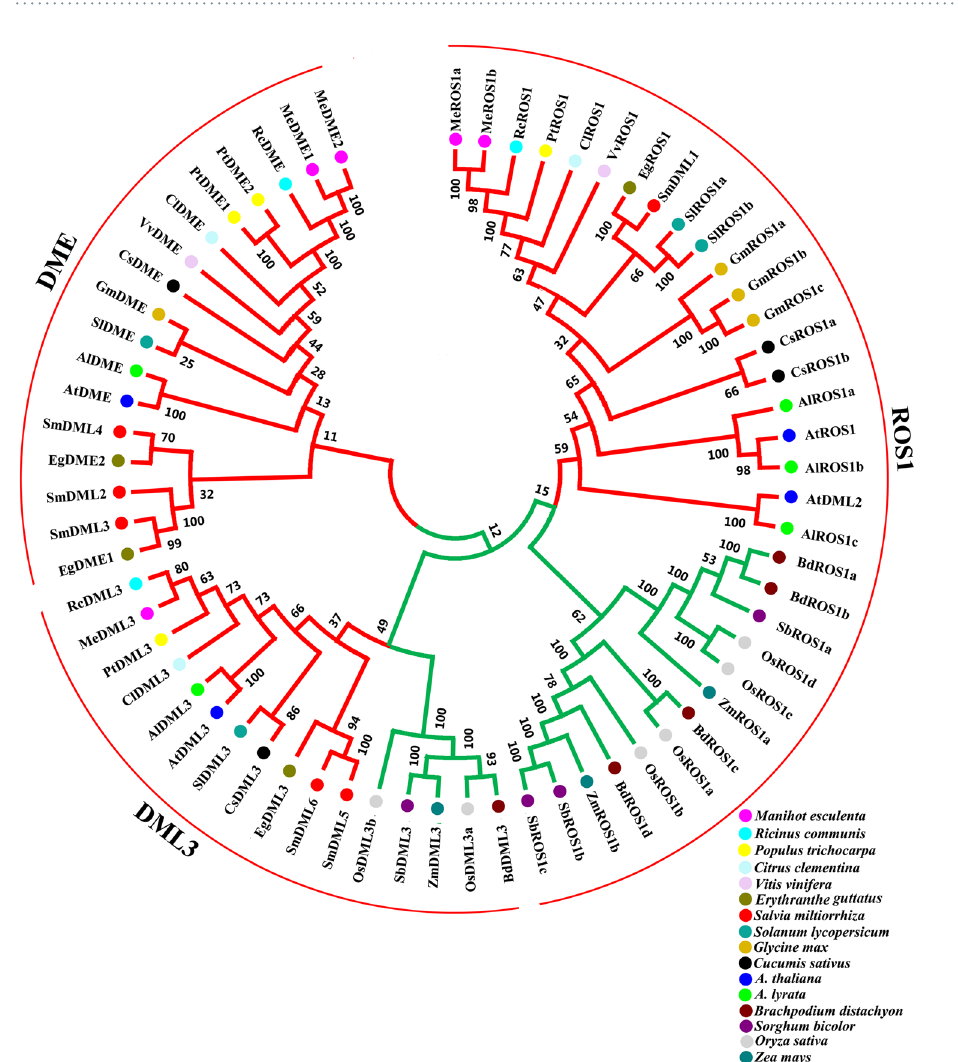
Figure 4. Phylogenetic analysis of DML proteins from 16 plant species. Monocot and dicot are colored green and red, respectively. The bootstrap values are